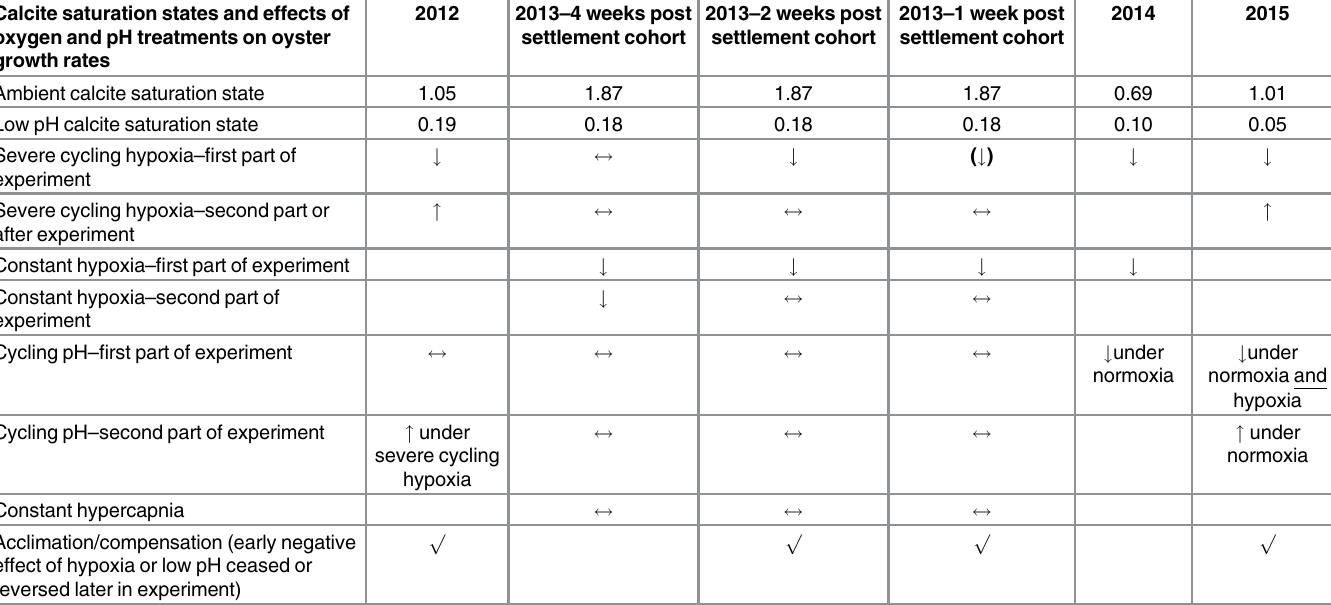
Table 3. Summary of Ω calcite and growth results from 2012 through 2015 experiments. Calcite saturation states and effects of oxygen and pH treatments on oyster growth